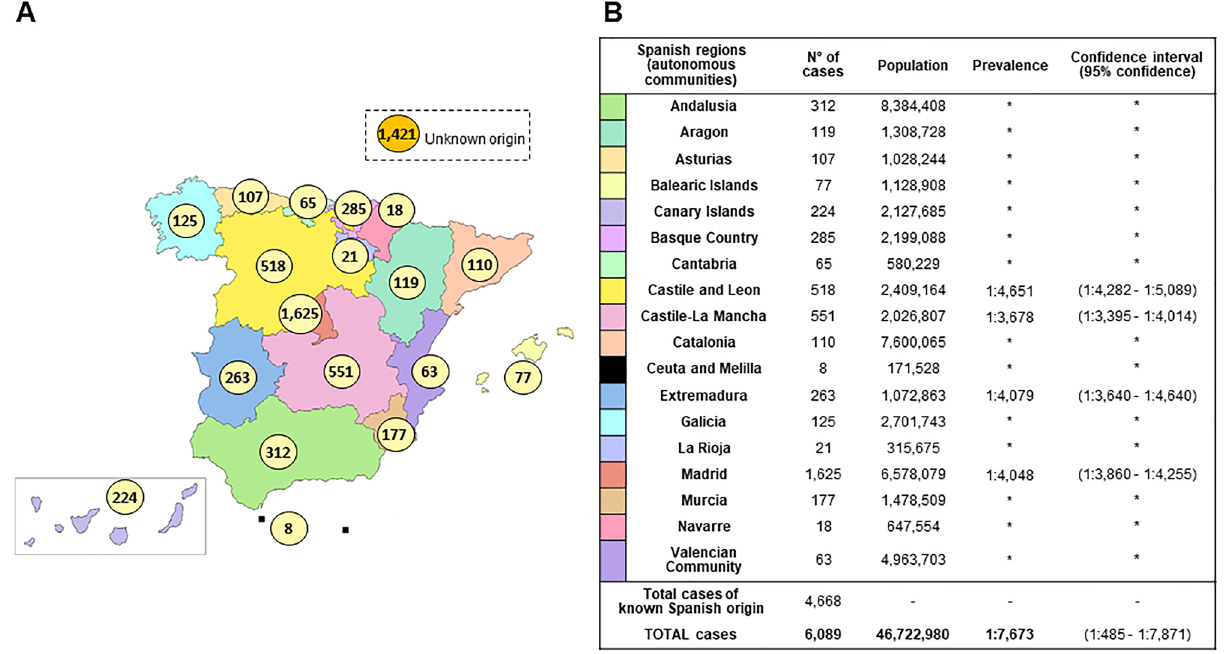
Figure 1. IRD affected cases distribution and estimated prevalence in Spain. ( A ) Distribution of RP/NON-RP affected cases across Spain. Total cases: 6089 (known Spanish origin: 4668; unknown origin: 1421). Spanish map modified using image editor from https:// www. veoma pas. com/ mapa- mudo- de- las- comun idades- auton omas- de- espana- m103. html. ( B ) IRD estimated prevalence in Spanish regions. Data was obtained from the number of cases we had in our Hospital Service and the recorded population in the different regions. *Inconclusive